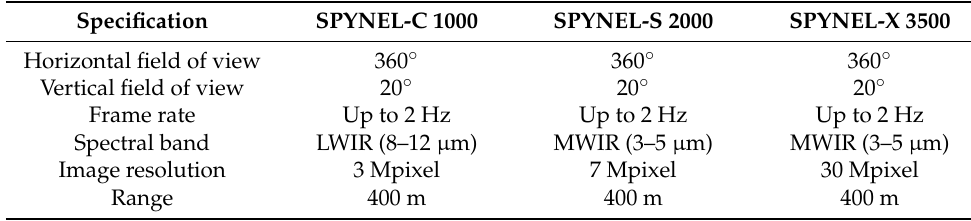
Table 12. Spynel series